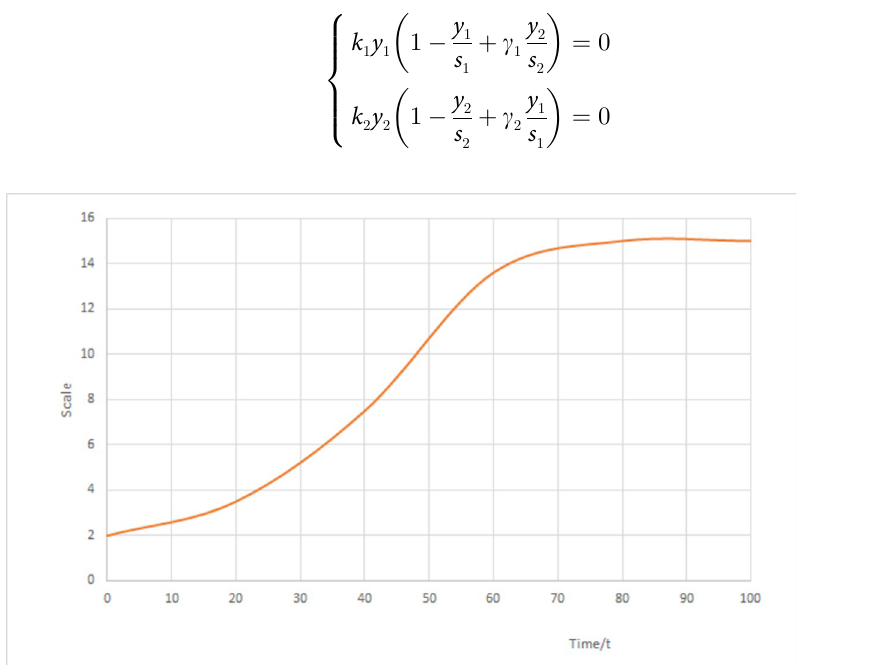
Fig 1. Evolution shape of urban-rural transport